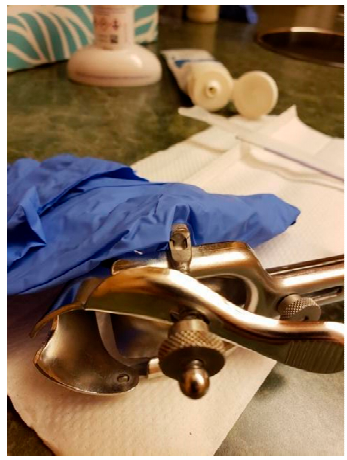
Figure 1. “Health Care—It’s Complicated” (HG).